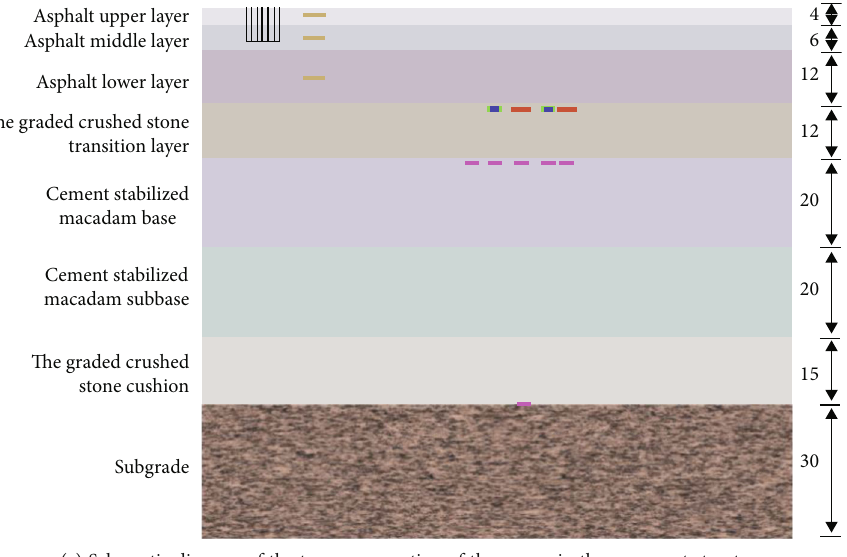
Figure 2: Schematic diagram of structure S3 sensing element (unit: cm).